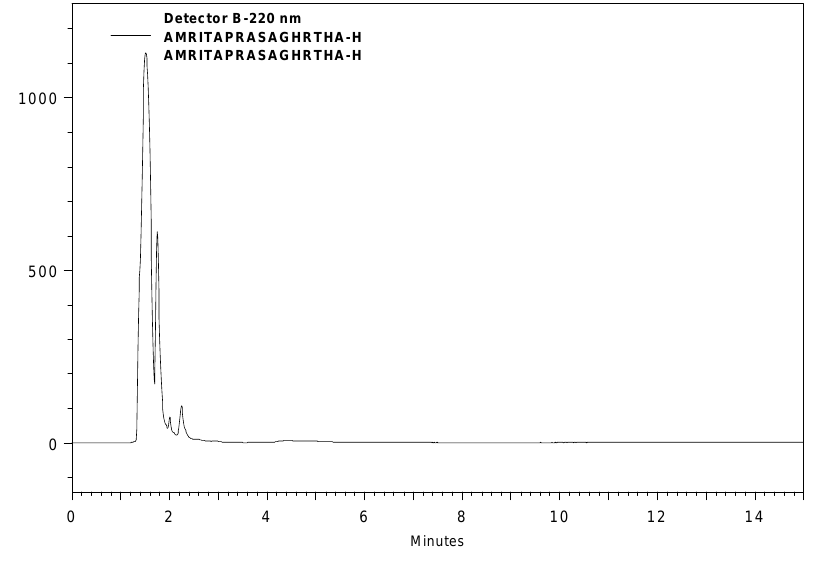
FIGURE 2FIGURE 2. HPLC CHROMATOGRAM OF BRAHMI